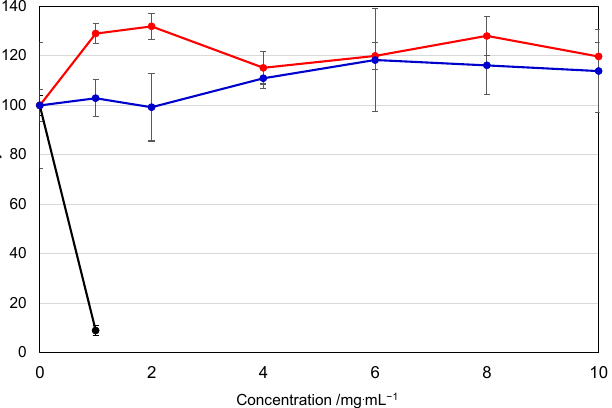
Figure 5. Effect of the APe-Im-Am-PEG or APe-Im-Es-PEG on the cell (HepG2) viability: APe-Im- Am-PEG (red), APe-Im-Es-PEG (blue), and bPEI (black: rapidly decreasing). Symbols and error bars represent the mean and standard deviation of the measurements made in triplicate wells.